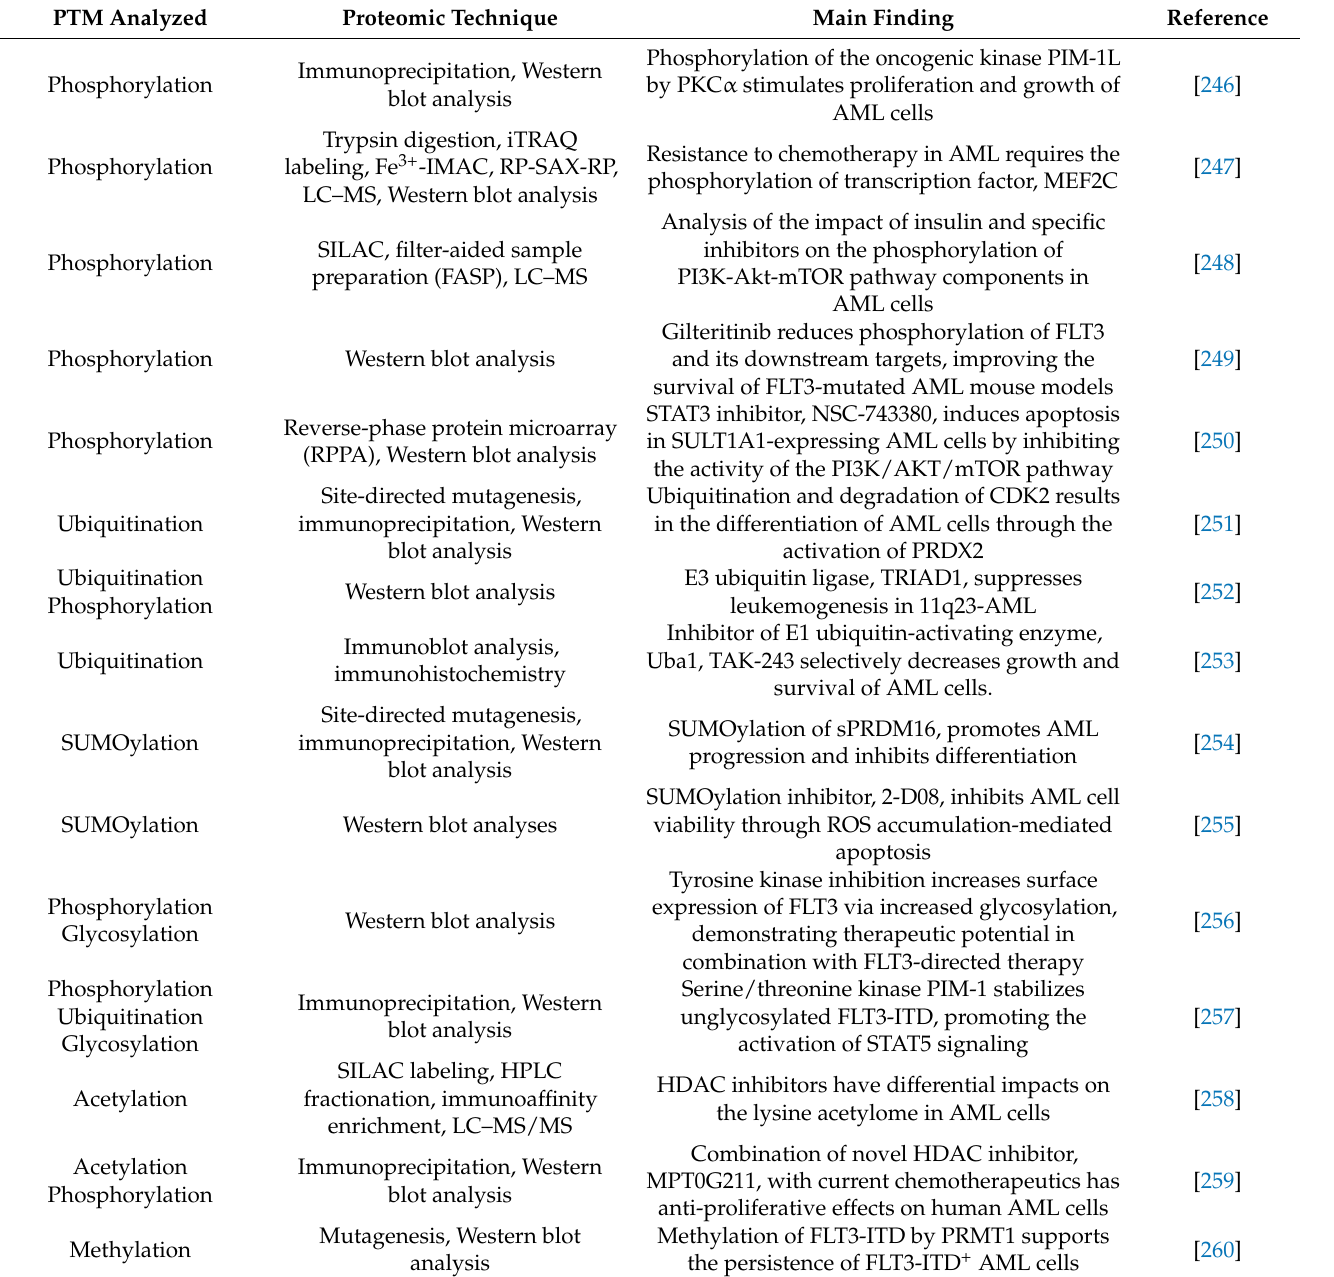
Table 3. Recent studies utilizing proteomic techniques to analyze PTMs in acute myeloid